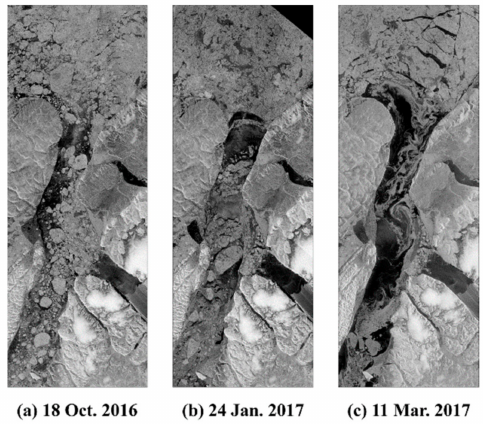
Figure 13. Sea ice conditions in the north of the Robeson Channel on different days during the 2016–2017 sea ice season.